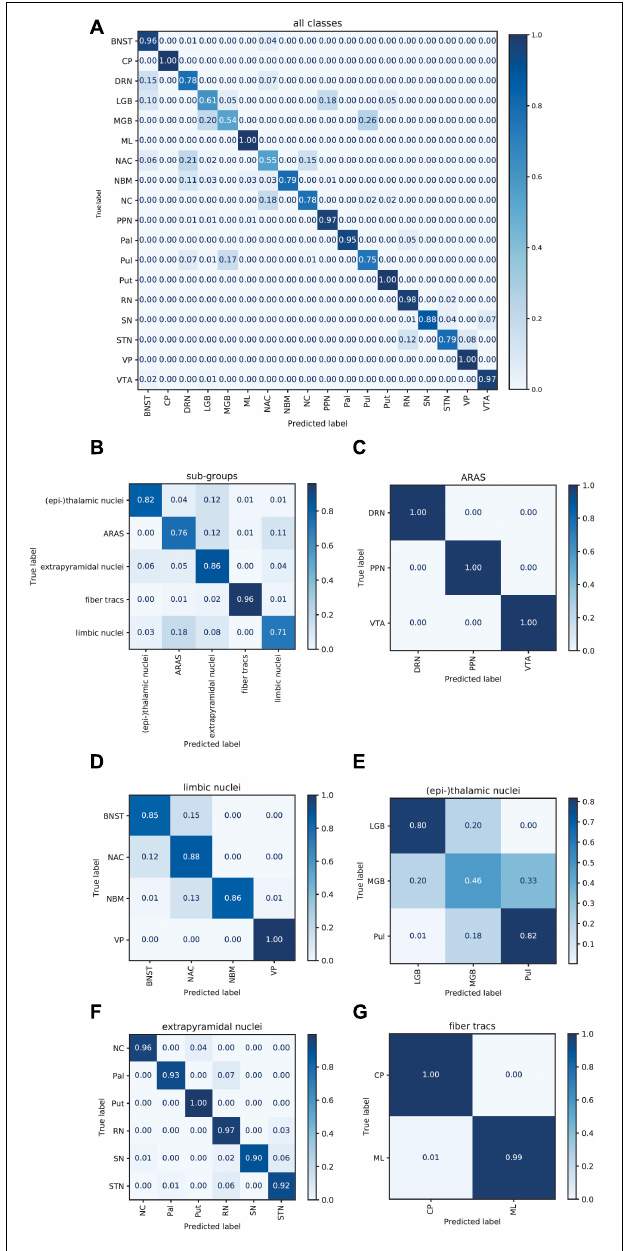
FIGURE 6 | Normalized sum of confusion matrices of five patients (mean values of 100 runs) for the classification of all subcortical structures (A) , the classification into functional groups (B) and the discrimination of nuclei of the epi-thalamic group (C) , the limbic group (D) , the ARAS (E) , the extrapyramidal nuclei (F) , and the fiber tracts (G) . The diagonal elements represent the probability of the predicted class being equal to the true class in values between zero and one. Off-diagonal elements are those mislabeled by the